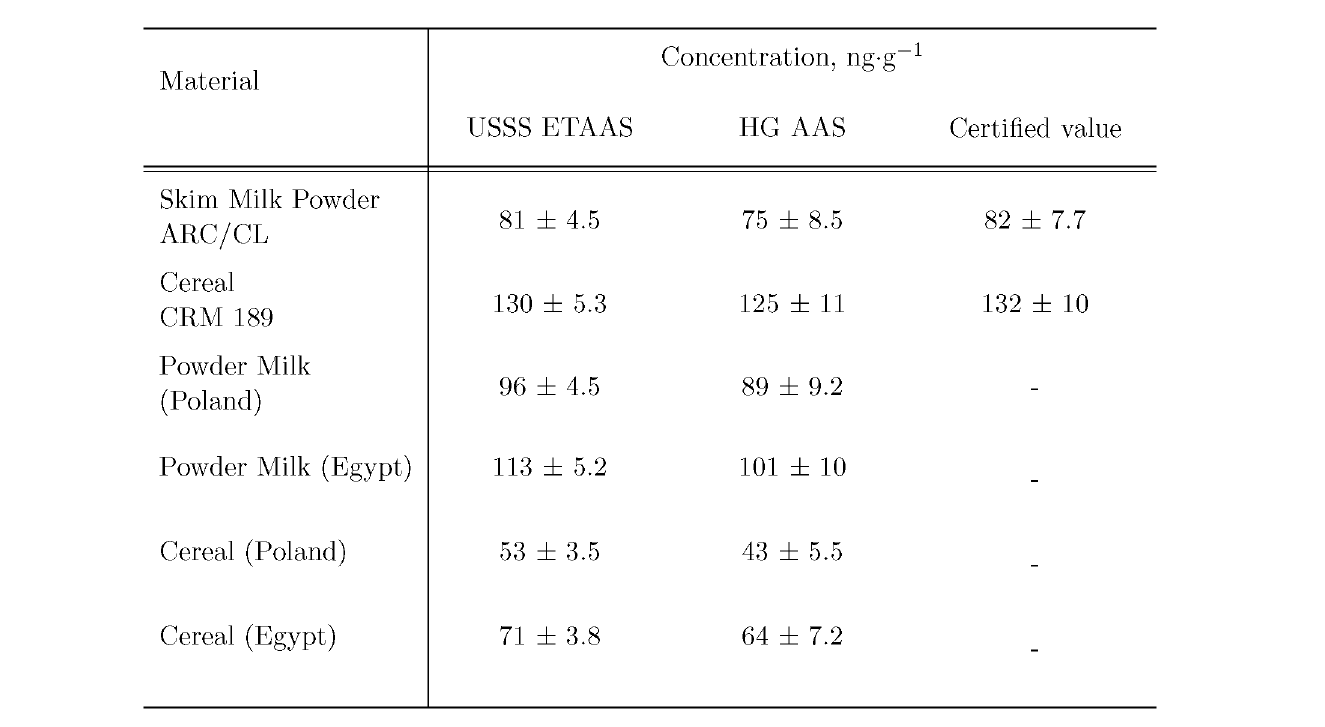
Table 3 Selenium content in two certified reference materials and four ,,real" samples of infant food as determined by USSS ETAAS and HG AAS (average values 4- standard deviation; n 6; P